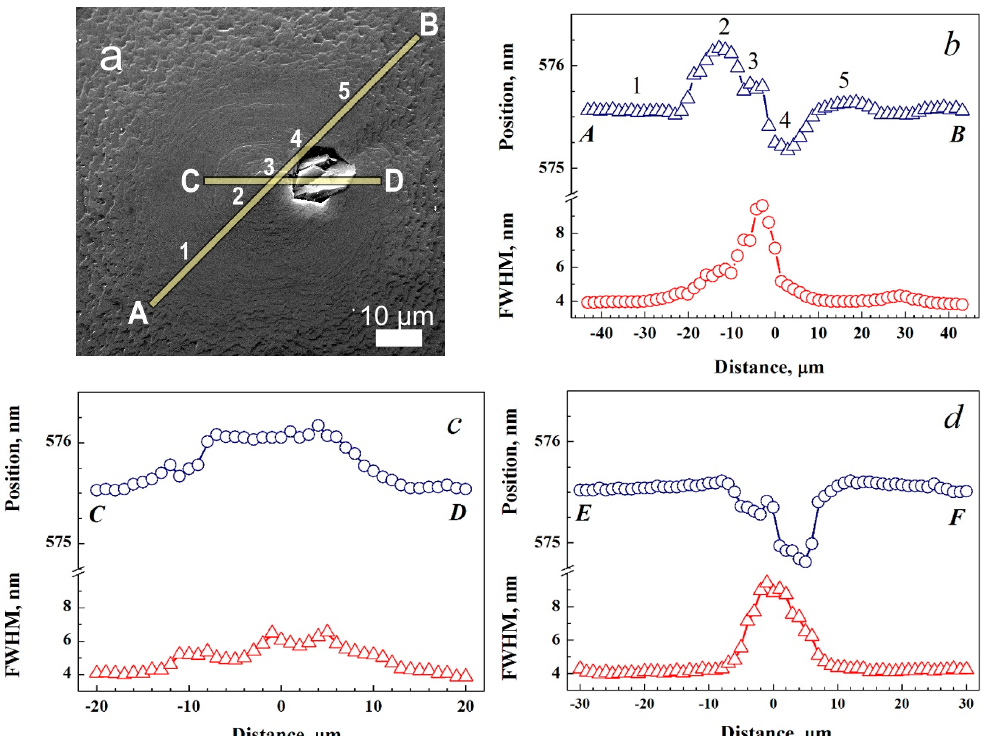
Figure 5. SEM image of a hillock with polycrystalline inclusion on the top. The lines A-B and C-D, which avoid or cross the polycrystalline inclusion, respectively, denote the direction of PL NV mapping ( a ); Variations of position (top curve) and the FWHM (bottom curve) of NV 0 ZPL at 575 nm along the lines A-B ( b ) and C-D ( c ); Variation position and width of PL at 575 nm peak along the line E-F crossing the top of another hillock without inclusions ( d ). The mapping step is 1.4 μ m for A-B and 1 μ m for C-D and E-F lines. The lines are guides for an eye. Locations # 1, 2…5 in ( a , b ) show positions where the PL spectra presented in Figure 4 have been taken.